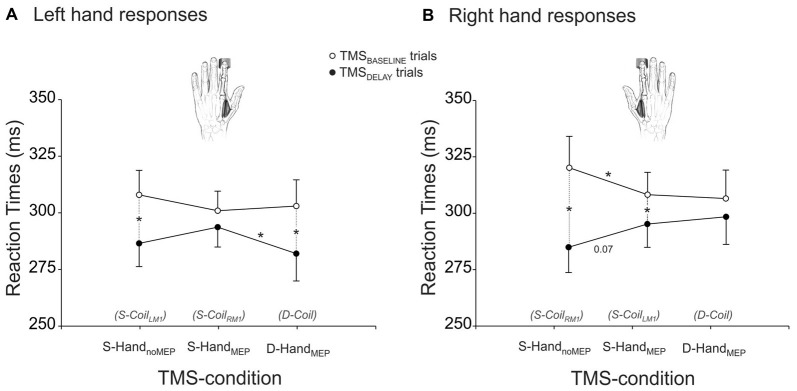
RTs (ms) of left (A) and right (B) responses provided with a hand that received MEPs in the Double-Coil block (D-Coil: D-HandMEP) or in the Single-Coil (S-CoilLM1 or S-CoilRM1: S-HandMEP) blocks or in a hand that did not receive MEPs in the S-CoilLM1 or S-CoilRM1 blocks (S-HandnoMEP). *Significantly different (p < 0.05).